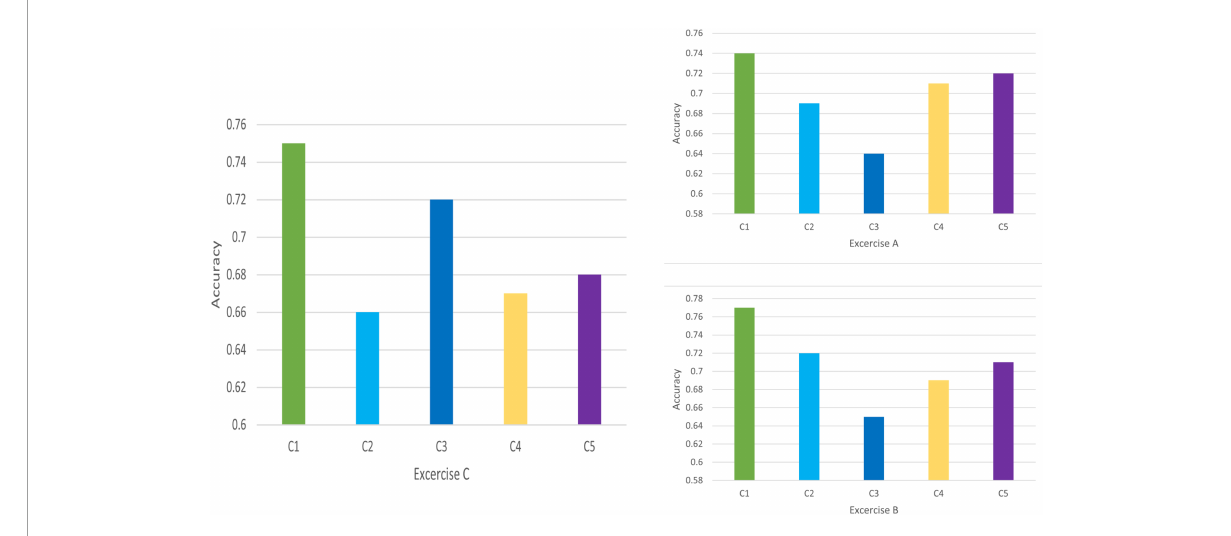
FIGURE8 Feature discrimination results for DB2.